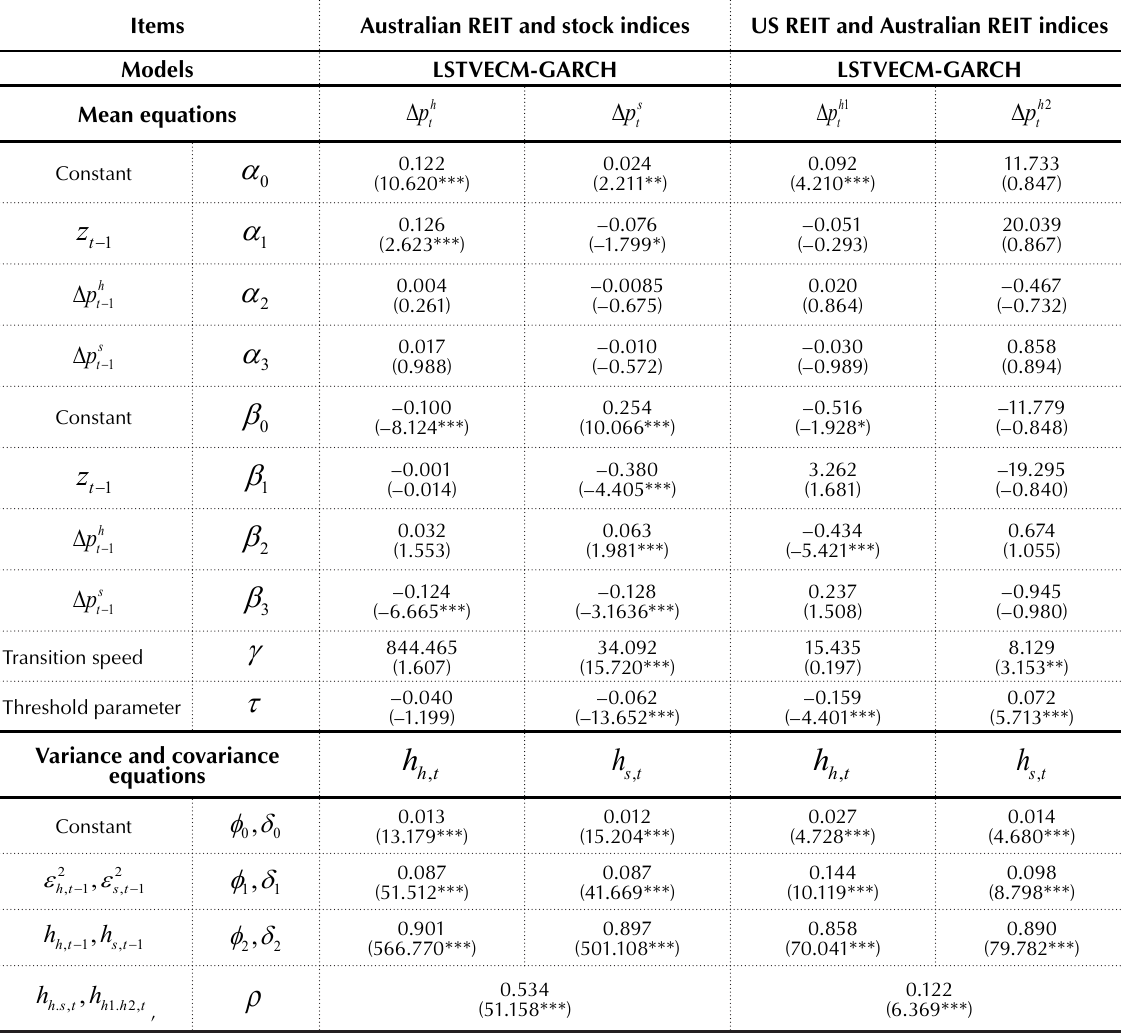
Table 5.2. Estimated results of models of Australian REIT and stock indices and US REIT and Australian REIT